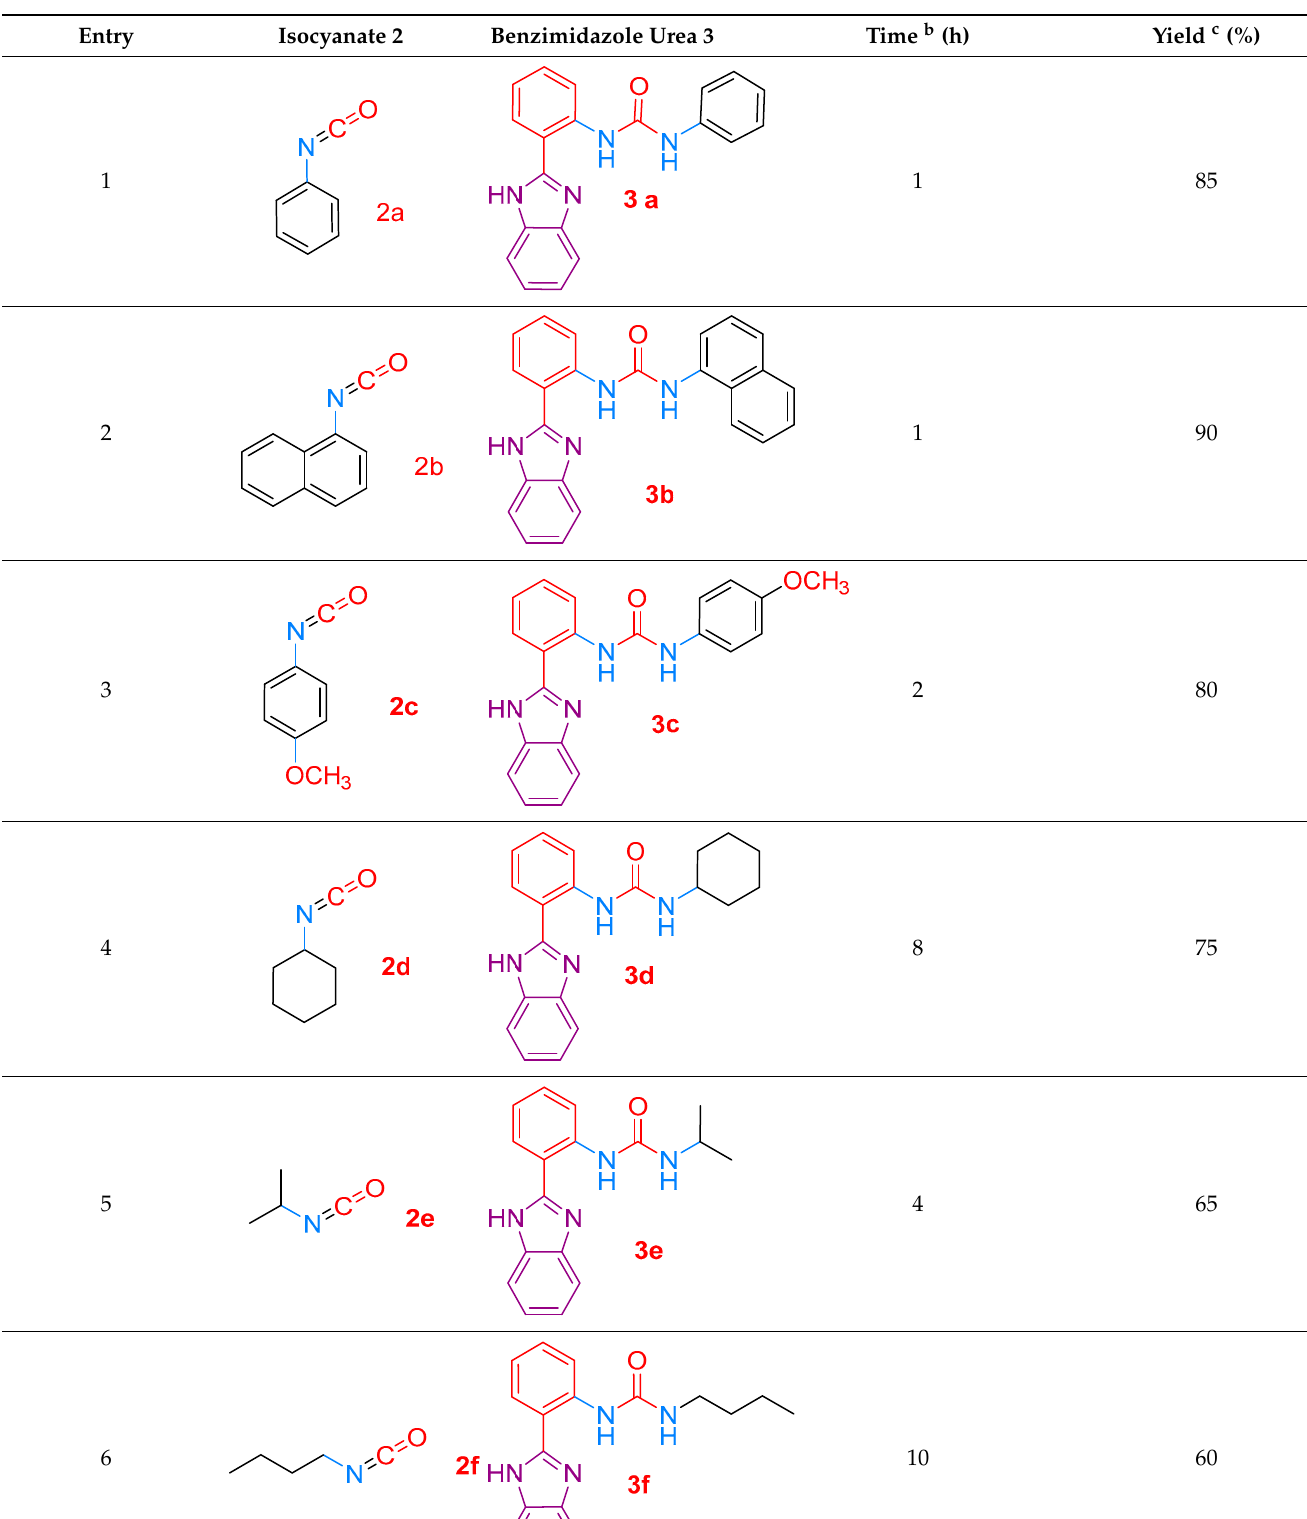
Table 1. Benzimidazole-ureas 3a-h synthesis from 2-(1 H -benzoimidazol-2-yl)aniline 1 and isocyanates Table 1 . Benzimidazole-ureas 3a-h synthesis from 2-(1 H -benzoimidazol-2-yl)aniline 1 and Table 1 . Benzimidazole-ureas 3a-h synthesis from 2-(1 H -benzoimidazol-2-yl)aniline 1 and 2a-h a . Table 1 . Benzimidazole-ureas 3a-h synthesis from 2-(1 H -benzoimidazol-2-yl)aniline 1 and Table 1 . Benzimidazole-ureas 3a-h synthesis from 2-(1 H -benzoimidazol-2-yl)aniline 1 and Table 1 . Benzimidazole-ureas 3a-h synthesis from 2-(1 H -benzoimidazol-2-yl)aniline 1 and Table 1 . Benzimidazole-ureas 3a-h synthesis from 2-(1 H -benzoimidazol-2-yl)aniline 1 and isocyanates 2a-h a . isocyanates 2a-h a . Table 1 . Benzimidazole-ureas 3a-h synthesis from 2-(1 H -benzoimidazol-2-yl)aniline 1 and isocyanates 2a-h a . Table 1 . Benzimidazole-ureas 3a-h synthesis from 2-(1 H -benzoimidazol-2-yl)aniline 1 and isocyanates 2a-h a . Table 1 . Benzimidazole-ureas 3a-h synthesis from 2-(1 H -benzoimidazol-2-yl)aniline 1 and Table 1 . Benzimidazole-ureas 3a-h synthesis from 2-(1 H -benzoimidazol-2-yl)aniline 1 and isocyanates 2a-h a . isocyanates 2a-h a . Table 1 . Benzimidazole-ureas 3a-h synthesis from 2-(1 H -benzoimidazol-2-yl)aniline 1 and Table 1 . Benzimidazole-ureas 3a-h synthesis from 2-(1 H -benzoimidazol-2-yl)aniline 1 and isocyanates 2a-h a . isocyanates 2a-h a . isocyanates 2a-h a . isocyanates 2a-h a